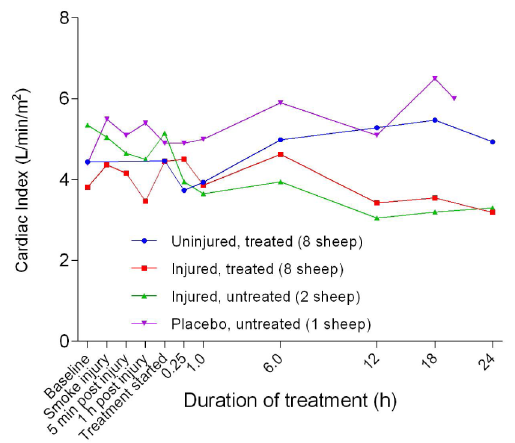
Figure 32. Pulmonary vascular resistance index (PVRI) (Mean ± SD, error bars not shown) in smoke and non-smoke injured sheep that received extracorporeal life support as compared to that in